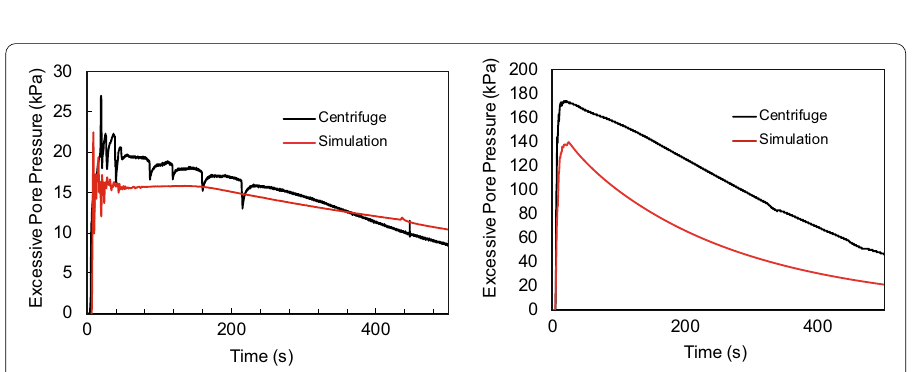
Fig. 9 Comparison of numerical and experimental results for excess pore water pressure at ‑2 m from top (left) and bottom of model